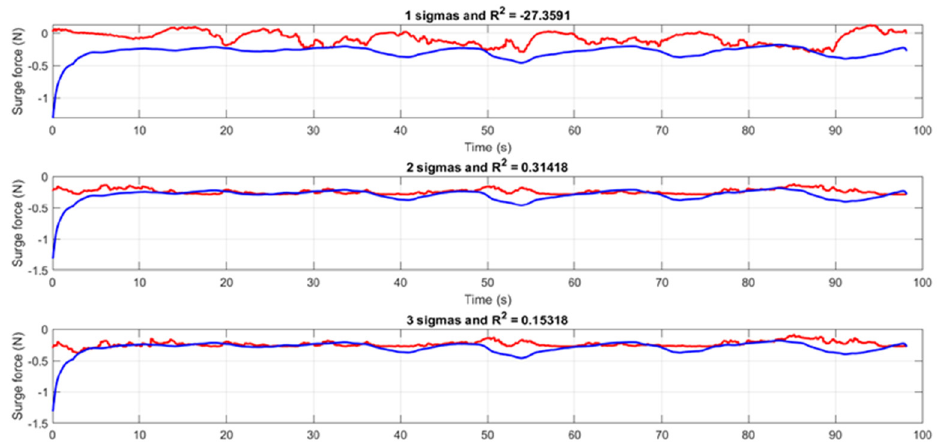
Figure 9. Measured (blue curves) vs. estimated surge force (red curves) for the tests’ data from the 30°–30° zigzag manoeuvre.